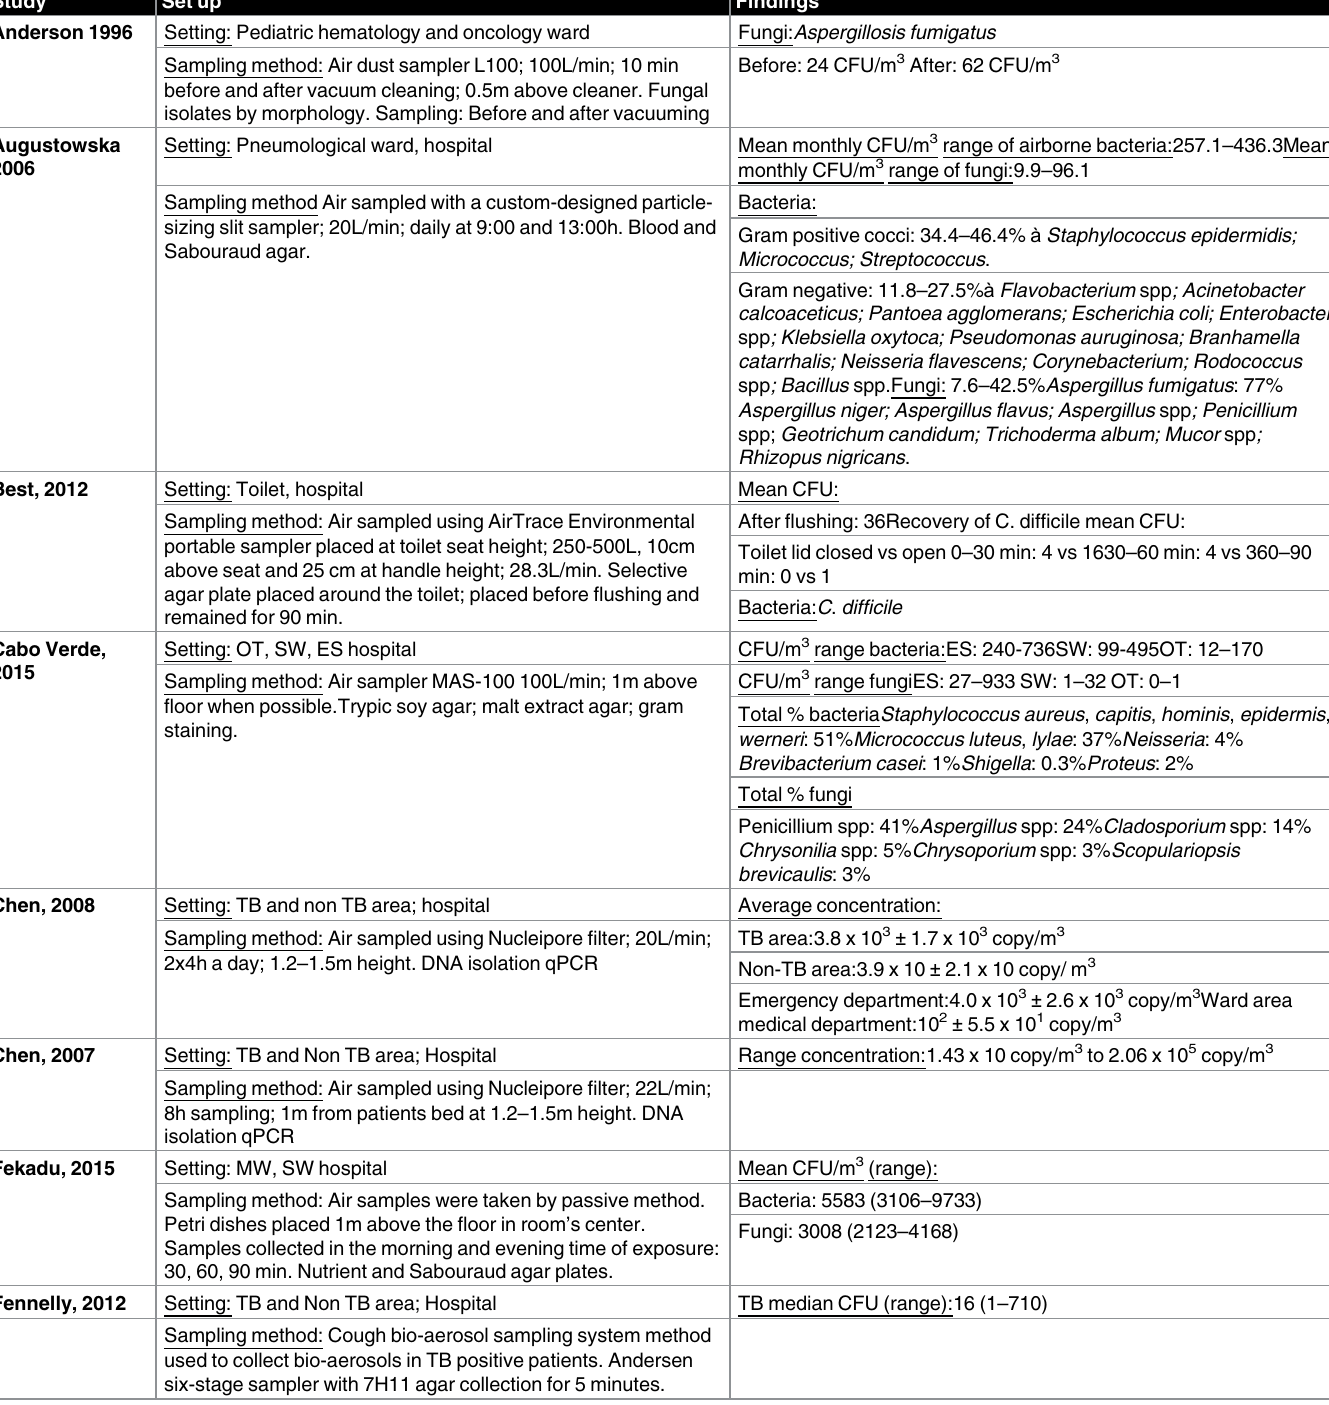
Table 2. Study characteristics hospital